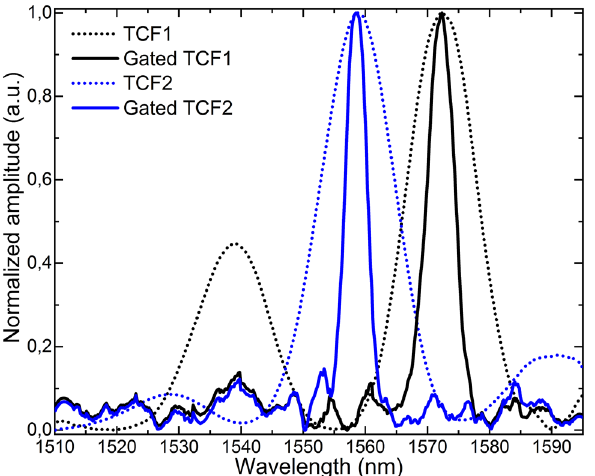
Figure 4. Spectra of the manufactured TCF sensors when they are probed by a broadband light source in a conventional open loop configuration (dotted line) and as part of a pulsed laser cavity, tuning the repetition frequency to the resonant cavity length of each (continuous